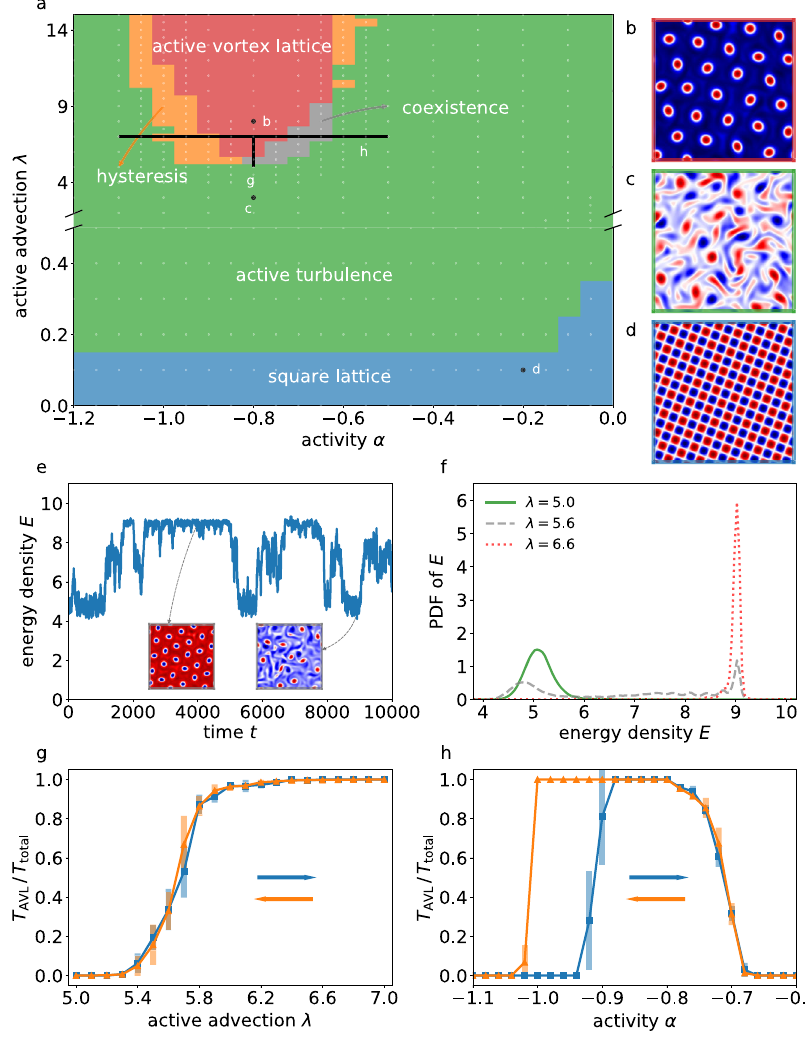
Fig. 1 Dynamical states and their transitions in the active fl uid model (domain size L = 20 π ). ( a ) Dynamical states as a function of activity and active advection, obtained from close to 1000 simulations (Methods). Red, green, and blue regions correspond to ( b ) active vortex lattice (AVL), ( c ) active turbulence (AT) and ( d ) square lattice states, respectively. The gray and orange regions are the marginal stability regions between the AT and the AVL states. The white dots show the parameter con fi gurations used to obtain the phase diagram (see also Fig. 6). ( e ) A typical energy density time series for a simulation in the marginal stability region ( α = − 0.8, λ = 5.6) illustrates the intermittent melting and organization of the AVL. The insets show representative snapshots of the vorticity fi eld. ( f ) Probability density functions of the energy density for values of λ = 5 (green), 5.6 (gray) and 6.6 (red). ( g ) AVL-AT transition as a function of active advection ( α = − 0.8, vertical black line in ( a )) and ( h ) transition along the activity axis ( λ = 7, horizontal black line in ( a )). The blue and orange curves correspond to increasing and decreasing values, respectively, of α and λ . The error bars signify the standard deviations calculated from fi ve independent datasets